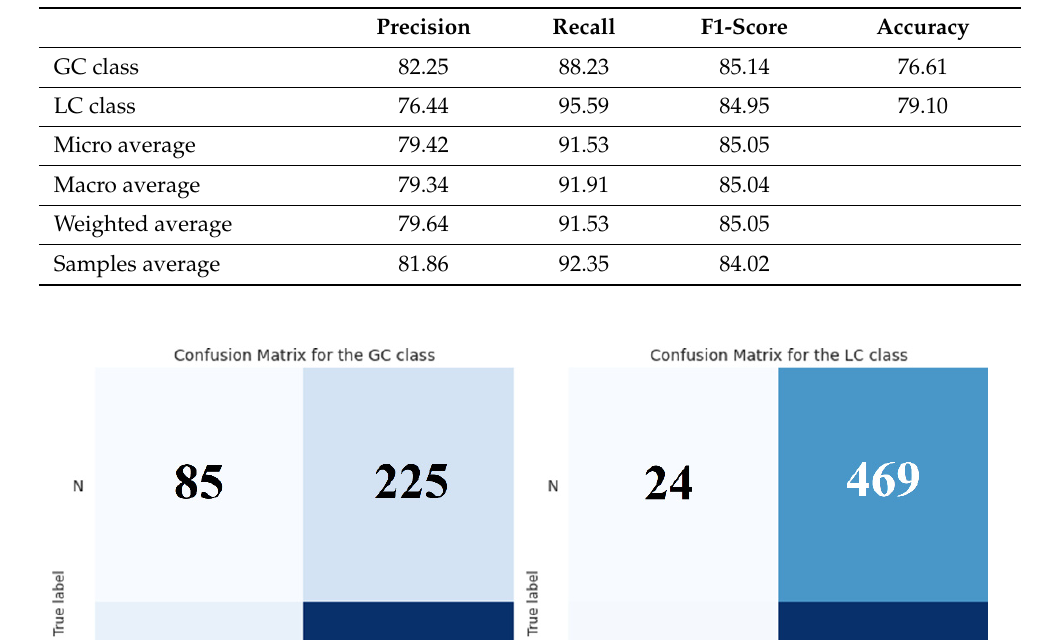
Table 4. Classification report of decision tree classifier.